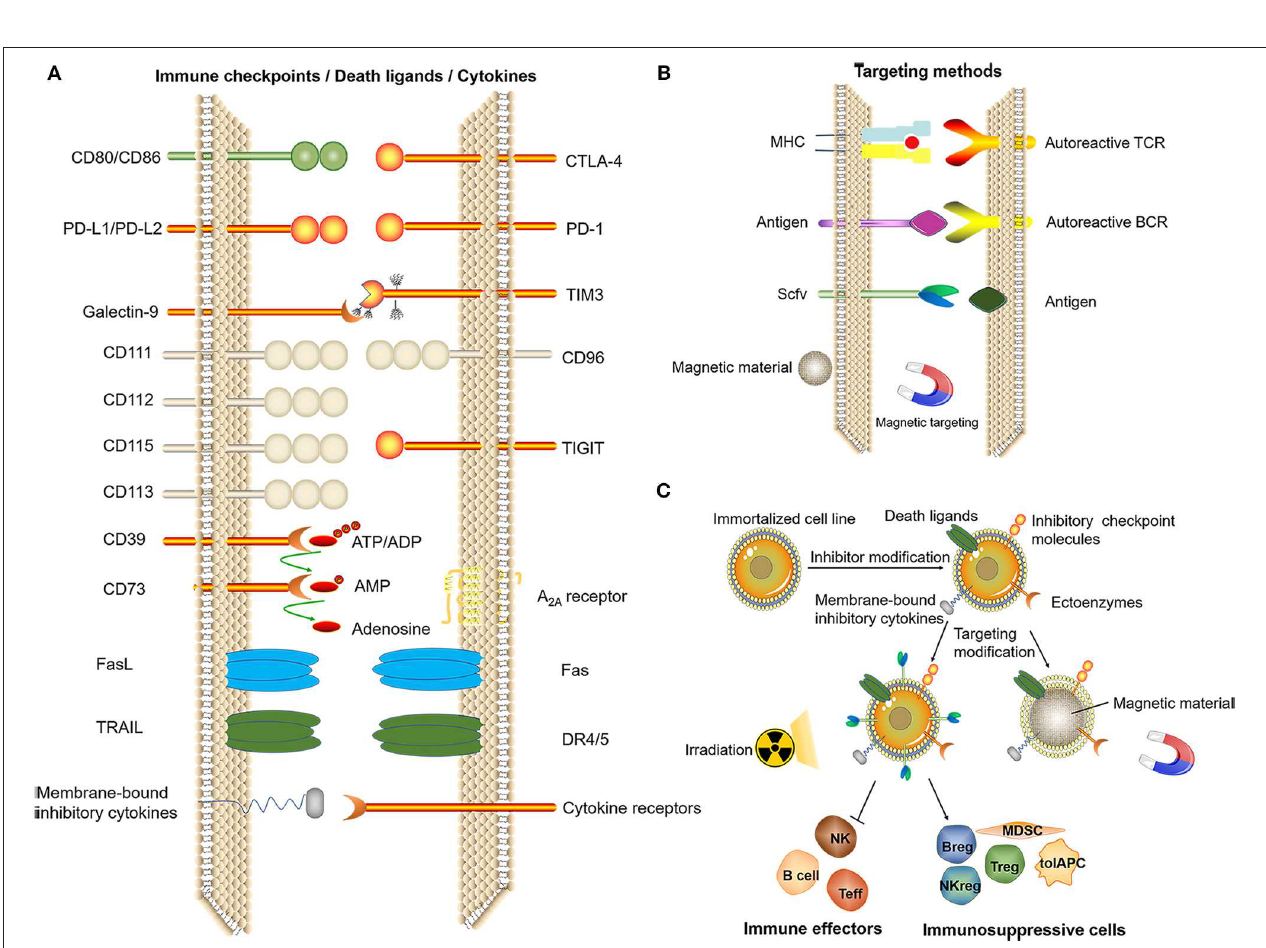
FIGURE 6 | Related technologies for tolerogenic cell therapy that can be mass-produced. (A) Induction of immune tolerance by immune checkpoints, death ligands, (artificial) membrane-type cytokines. (B) Targeting methods. (C) Genetic modification of immortalized cell lines and screening to obtain cells with the ability to induce immune tolerance after irradiation for treatment or by using the cell membrane to bind magnetic materials, thus exerting an immunomodulatory effect at a specific site under the action of a magnetic field.